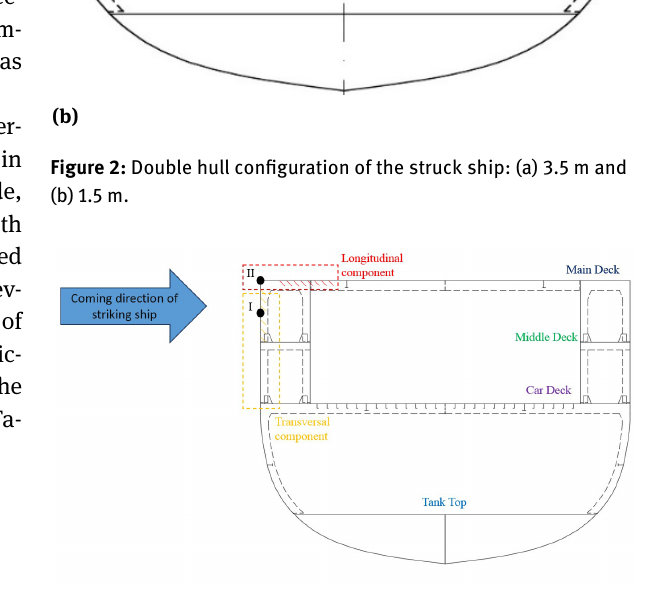
Figure 3: Impact scenario model based on component preference